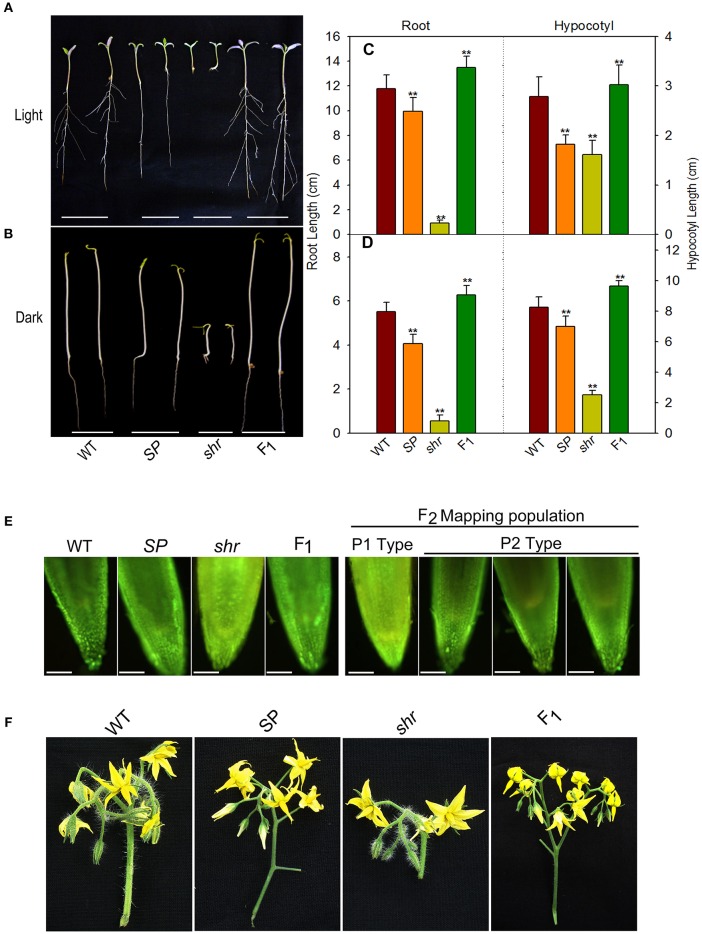
Genetic segregation of phenotypic traits in shr mutant. Seedling phenotype (A,B), root and hypocotyl length (C,D) of Ailsa Craig (WT), S. pimpinellifolium (SP), short root (shr) mutant and F1seedlings grown in light (A,C- 9-day old seedlings) and darkness (B,D- 5-day old seedlings). (E) NO levels in root tips of 9-day old light-grown seedlings of parent plants (left panel) and mapping population (right panel) using NO-sensitive dye DAF-2DA. In F2 mapping population, short-root seedlings showed NO staining similar to shr mutant parent(P1 type) and long-root seedlings showed NO staining similar to SP parent (P2 type). (F) Inflorescence morphology of WT, SP, shr and F1 plants. The values are the mean ±SD (n = 79 seedlings). Asterisk indicates statistically significant difference between WT and SP, shr, and F1(One-Way ANOVA;**
P <0.001). In fluorescence microscopic picture of the root, scale bar corresponds to 10x zoom micro scale, Olympus BX51.